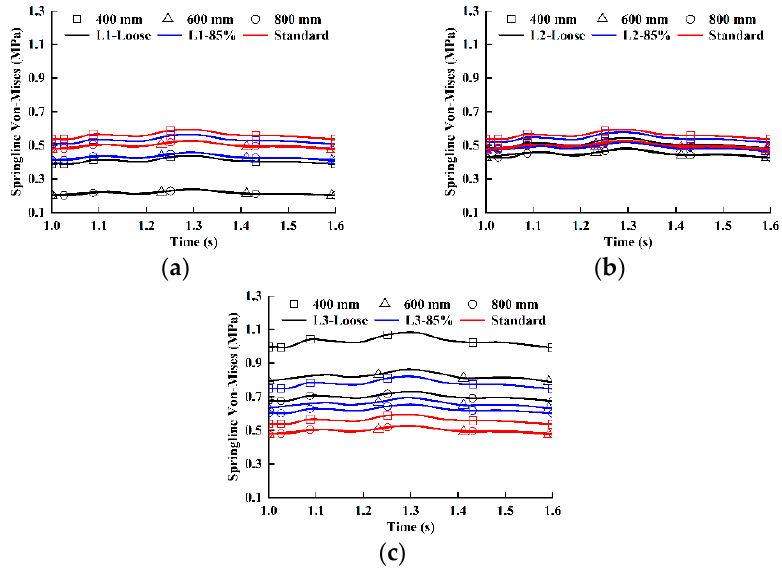
Figure 14. The springline Von-Mises stress of different diameter pipes under traffic load: ( a ) change in L1 compaction degree; ( b ) change in L2 compaction degree; ( c ) change in L3 compaction degree.